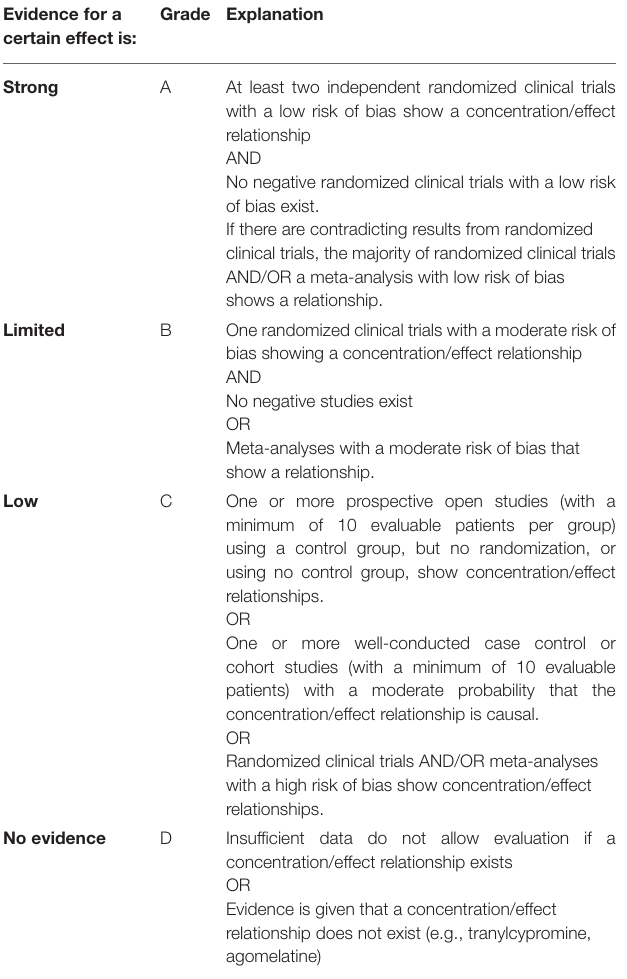
TABLE 2 | Grading into levels of evidence for a concentration/effect relationship following the recommendations of the WFSBP guidelines for clinical guideline